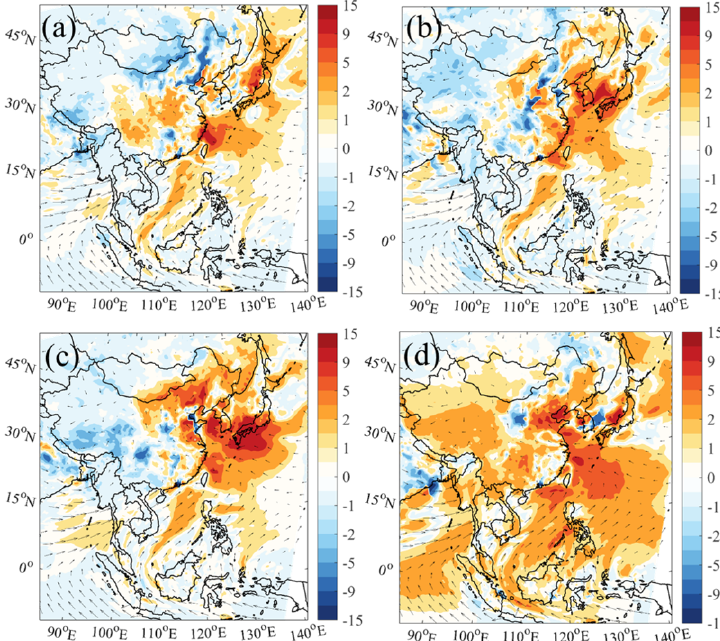
Figure 6. The 24h averaged ozone changes (06:00–18:00LST; in ppbv) due to ship emissions with (a) default chemistry (Def − Def_noship), (b) default and additional HONO chemistry (HONO − HONO_noship), (c) default and additional chlorine chemistry (Cl − Cl_noship), and (d) default and combined HONO and chlorine chemistry (BASE − BASE_noship). The arrows present simulated wind vectors from the BASE case.